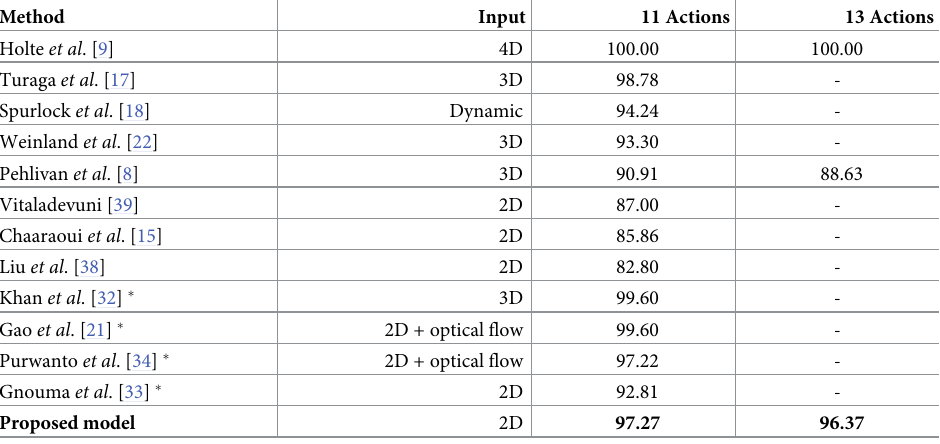
Table 3. Comparison for recognition (%) using the proposed model with state-of-the-art methods on IXMAS. Method